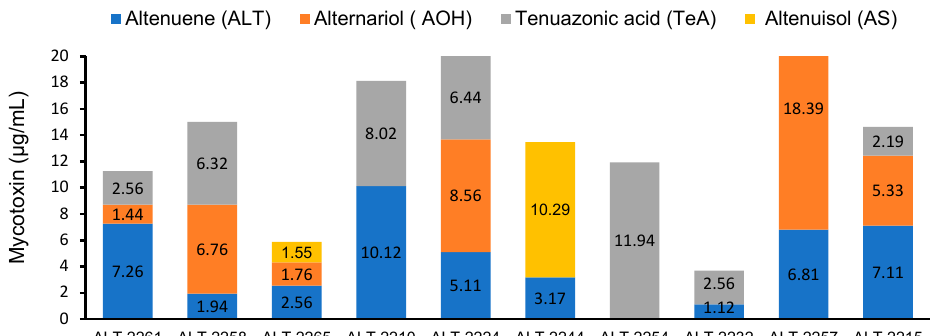
Figure 3. Graphical representation of the HPLC analysis results of the screened mycotoxins altenuene (ALT), alternariol (AOH), tenuazonic acid (TeA), and altenuisol (AS) and their varying concentrations from pathogenic isolates of A. altrnata .